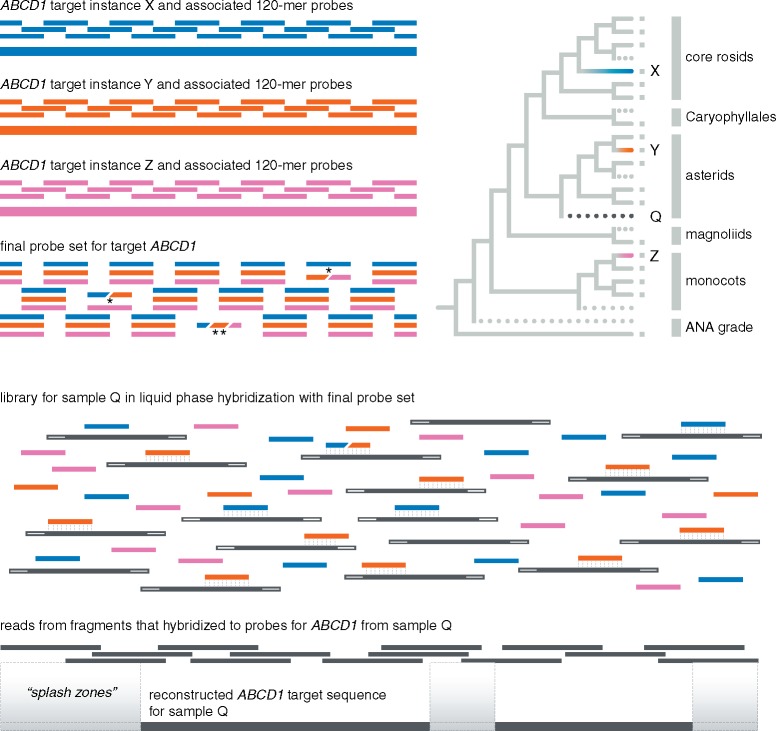
Overview of probe design and phylogenetic considerations. Given a hypothetical gene ABCD1, the goal of probe design is to include a sufficient diversity of 120-mers (probes) such that any angiosperm ABCD1 sequence can be recovered by hybridization. If a number of ABCD1 sequences are known, represented by solid branches and tips with a small gray square in the phylogeny, the minimum number of representatives of those sequences should be selected that maximize the chances of recovering ABCD1 from any “unknown” sample (dotted lines in the phylogeny). If sequences X, Y, and Z are selected, 120-mer probes are designed, here with 2\documentclass[12pt]{minimal}
\usepackage{amsmath}
\usepackage{wasysym}
\usepackage{amsfonts}
\usepackage{amssymb}
\usepackage{amsbsy}
\usepackage{upgreek}
\usepackage{mathrsfs}
\setlength{\oddsidemargin}{-69pt}
\begin{document}
}{}$\times$\end{document} tiling, across the entire length of the sequence. The final probe set includes all unique 120-mers; asterisks represent cases in which individual 120-mers are identical from two (*) or all three (**) of the representative sequences X, Y, and Z. In these cases only one or two 120-mers, rather than three, would be necessary for that region of the gene in the final probe set. While this is possible in probe design, we did not encounter any such cases in the Angiosperms353 probe set. For a particular “unknown” sample, here represented by the dark gray dotted line and denoted as sample Q, a sequencing library consisting of size-selected inserts, adapters, and indexes, is hybridized to the final probe set and the resulting sequence reads can be reconstructed to extract both the coding region and flanking non-coding (“splash zone”) regions. In this simplified example, the final probe set represents only gene ABCD1 but the Angiosperms353 final probe set includes probes tiled across 353 genes.